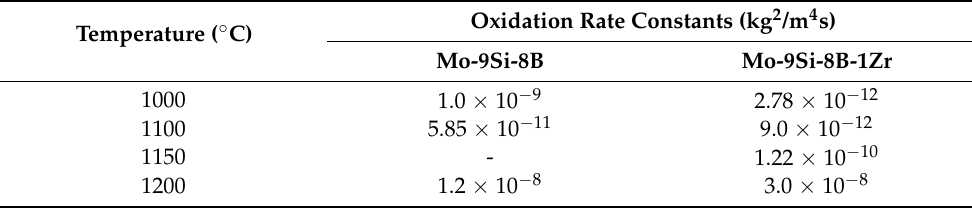
Table 1. The oxidation rate constants (kg 2 /m 4 s) of Mo–9Si–8B–(1Zr) at 1000–1200 ◦ C. Reproduced with permission [55]. Copyright 2009 Springer